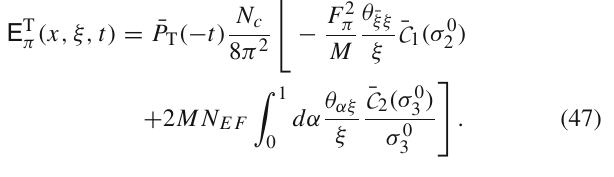
GPD is continuous but not differentiable at x = ± ξ .